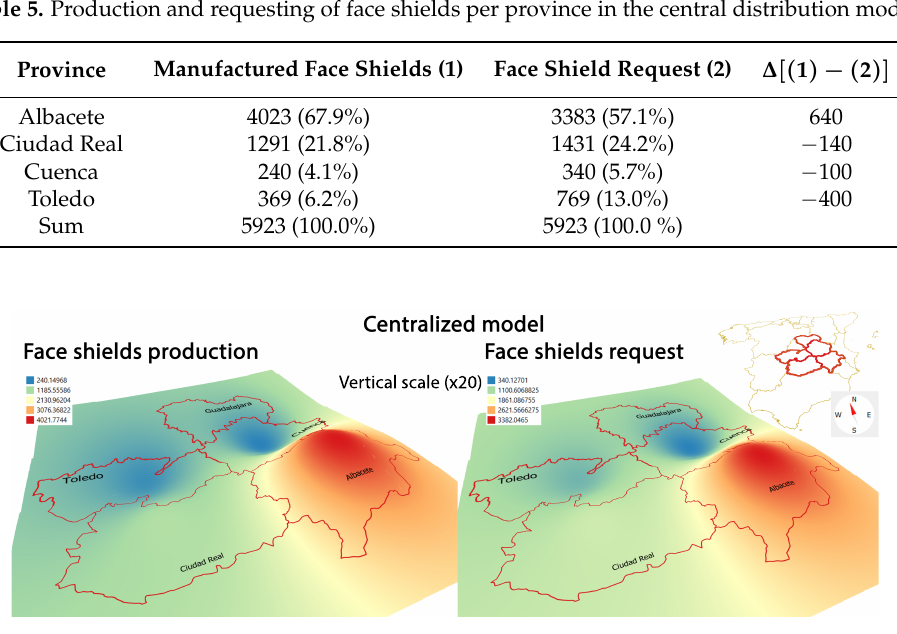
Figure 10. 3D production volume and delivery maps of face shields in the central distribution model with the same perspective point and vertical scale ( ×